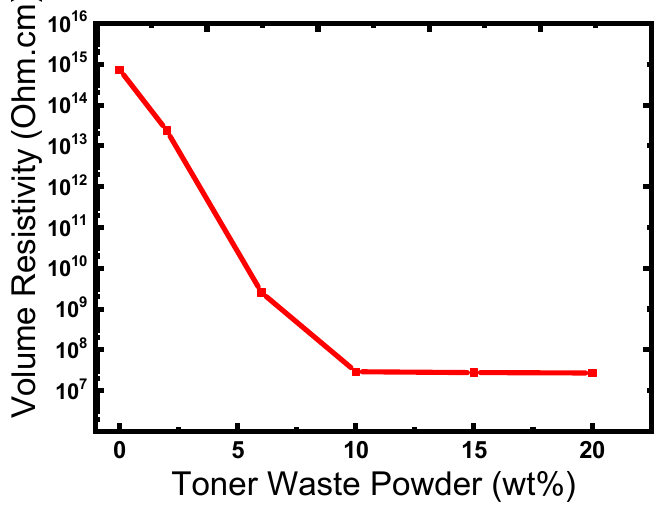
Figure 8. Volume resistivity variation as function of TWP loaded in LDPE/HIPS/TWP composites.